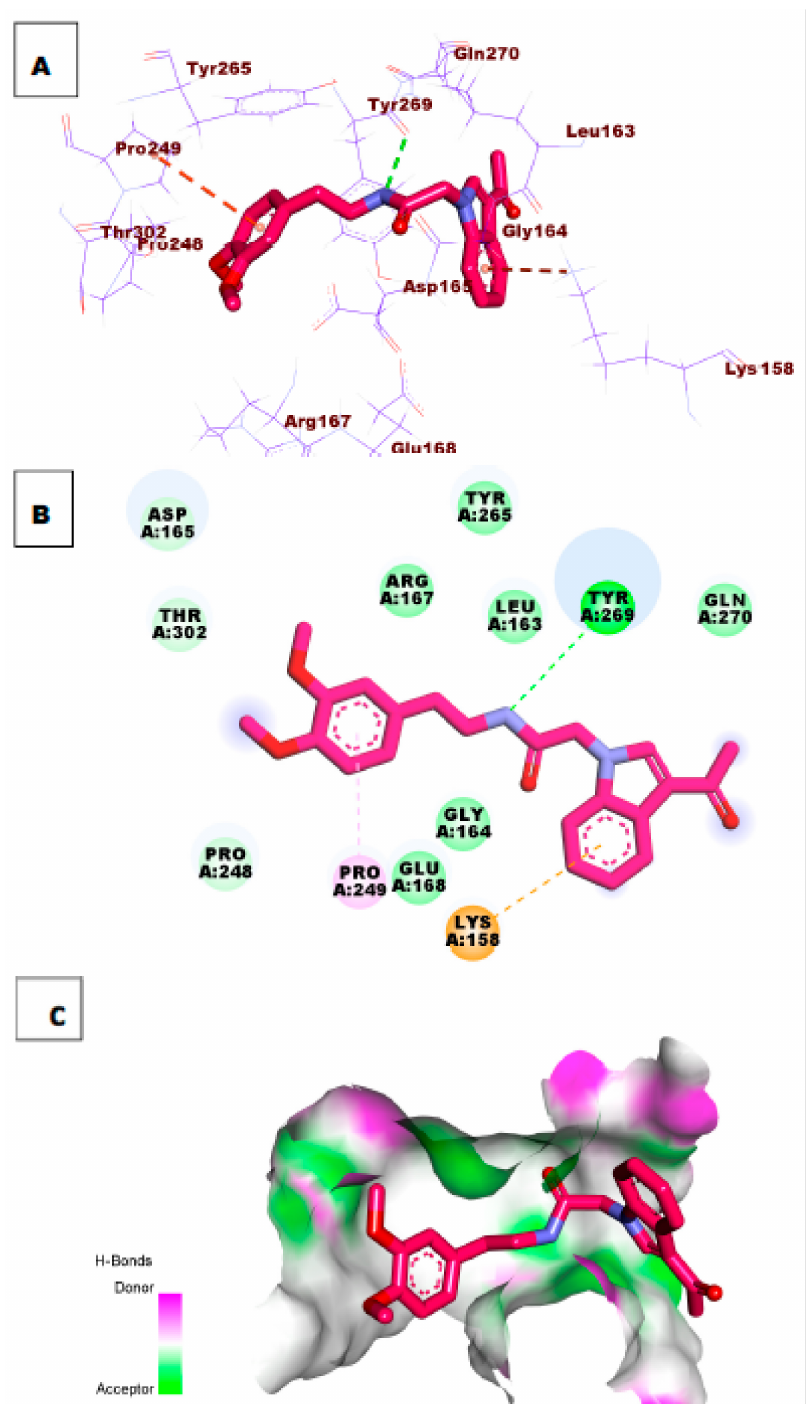
Figure 8. ( A ) 3D of compound 47 docked into the active site of PLpro. ( B ) 2D of compound 47 docked into the active site of PLpro. ( C ) Surface mapping of compound 47 docked into the active site of